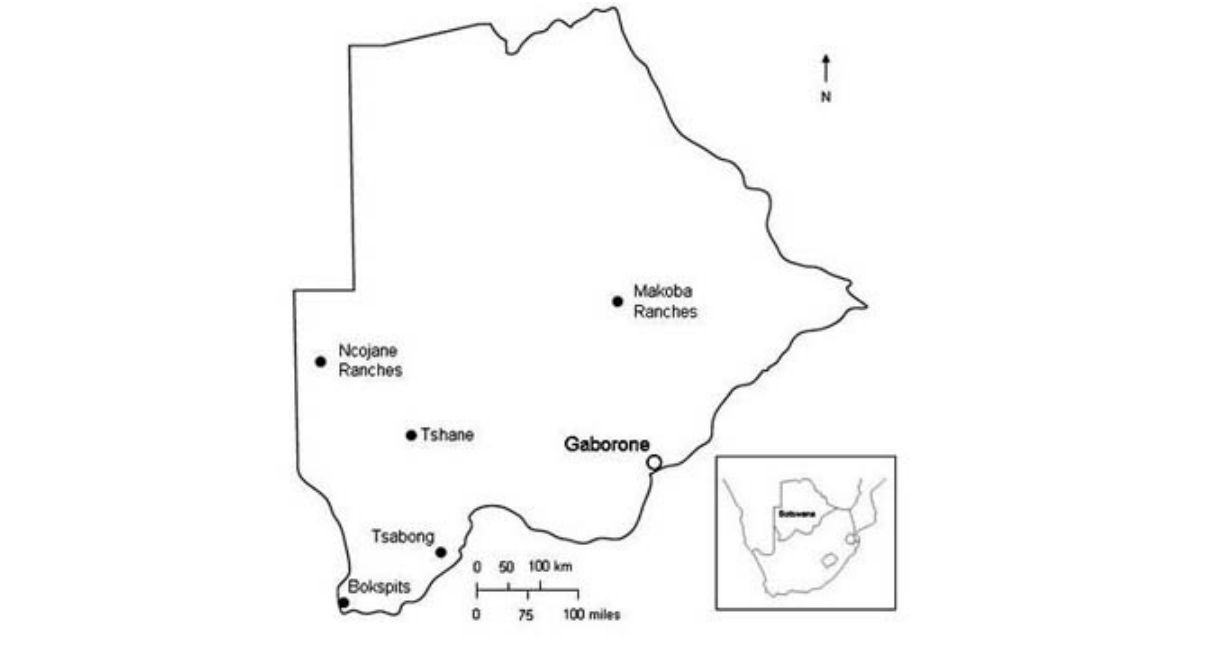
Fig. 1 . Location of research sites upon which expert knowledge and farmer interviews are